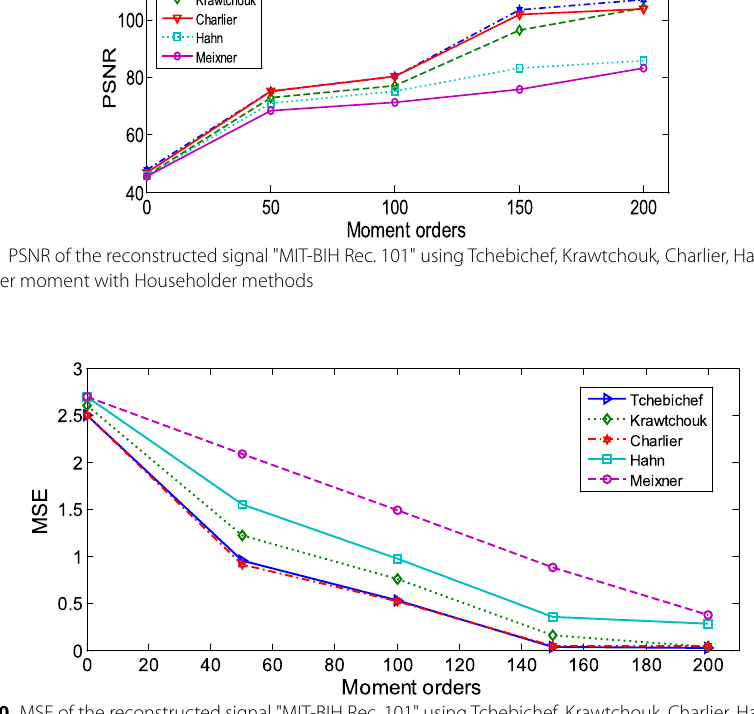
Fig. 10 MSE of the reconstructed signal "MIT-BIH Rec. 101" using Tchebichef, Krawtchouk , Charlier, Hahn, and Meixner moment with Householder